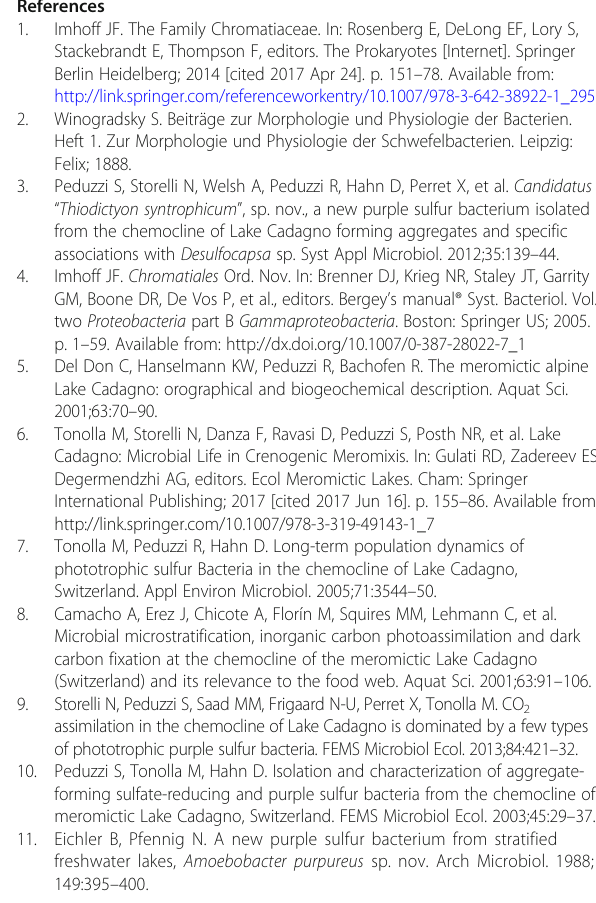
Additional file 1: Figure S1. Phylogenetic placement of “ T. syntrophicum ” strain Cad16 T within the other 12 Chromatiaceae species with a publicly available whole genome sequences. Additionally, the closely related phylogenetic lineages Nitrosococcus , Rheinheimera and Arsukibacterium are also included. Strain Cad16 T is most closely related to L. purpurea DSM 4197. The maximum likelihood tree was inferred from 100 concatenated single-copy orthologues sequences [61] and a total of 1000 bootstrap replicates were performed. Numbers at the nodes indi- cate the SH-aLRT support (%) and ultrafast bootstrap support (%). OrthoMCL [64], was used to define at set orthologues proteins between these 23 species. Hundred single-copy orthologues were randomly chosen and aligned with MUSCLE [66] . The best-fit phylogenetic model and subsequent consensus tree computation, based on maximum- likelihood and 1000 bootstrap iterations, was performed with the